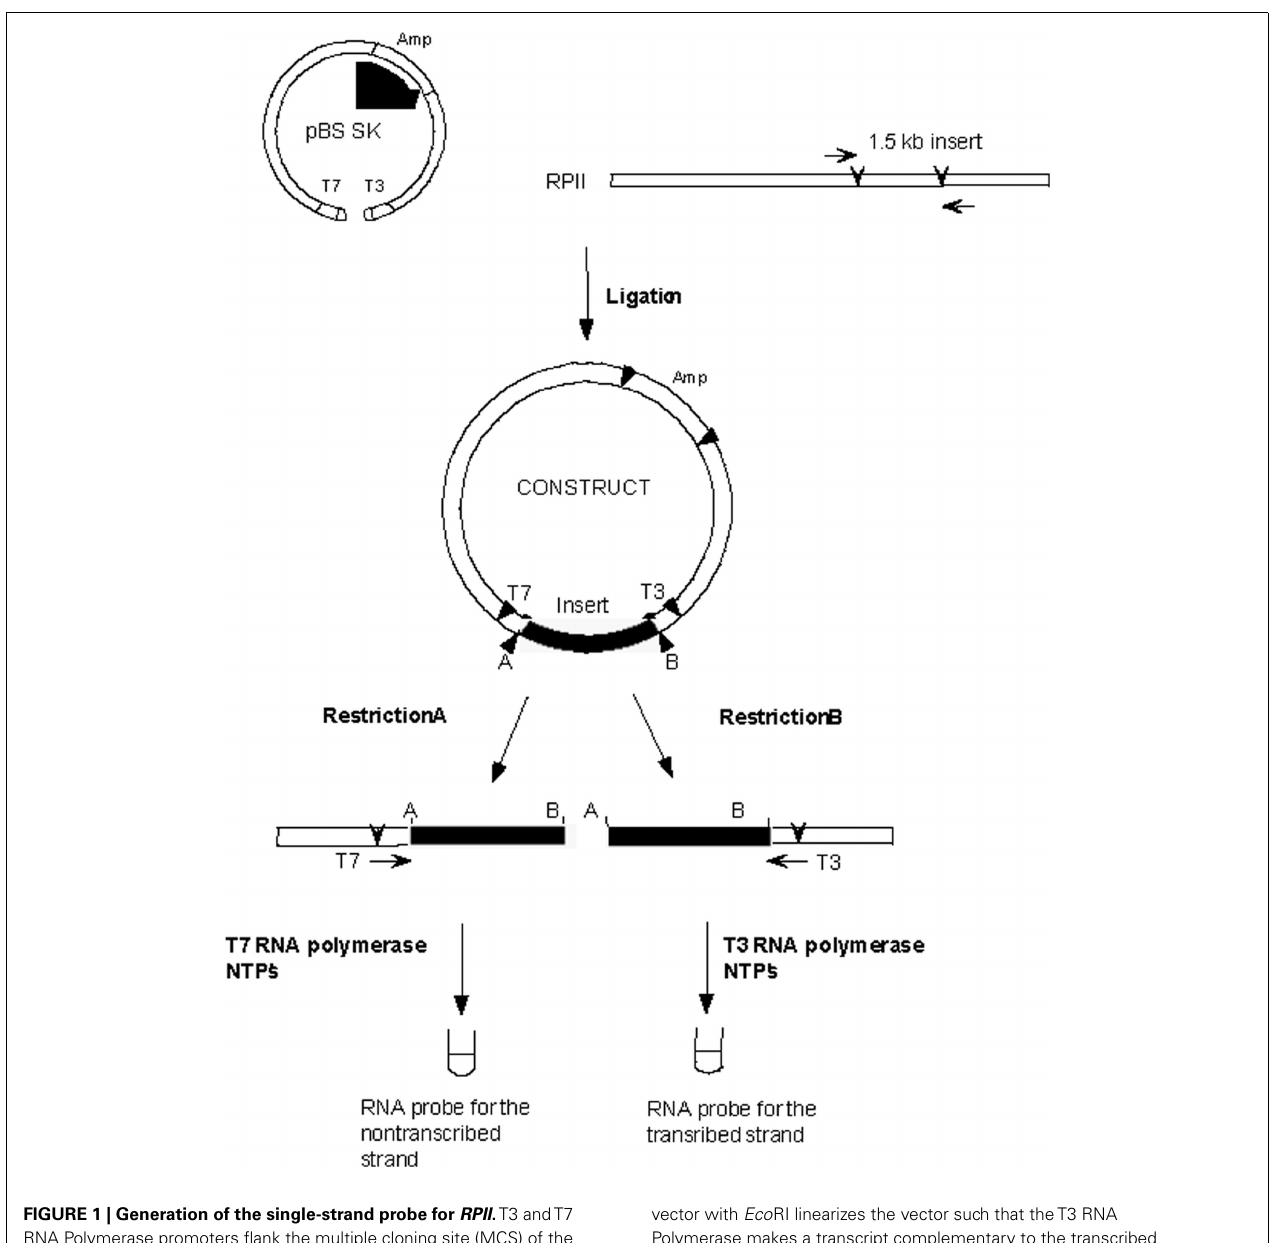
vector with Eco RI linearizes the vector such that theT3 RNA Polymerase makes a transcript complementary to the transcribed strand of the RPII gene. Digestion of the vector with Xba I linearizes the vector so that theT7 RNA Polymerase makes a transcript complimentary to the non-transcribed strand of the RPII gene. Addition of RNA synthesis reaction components (appropriate RNA Polymerase and radiolabeled NTPs) produces the probes for detection of each of the DNA strands of the RPII